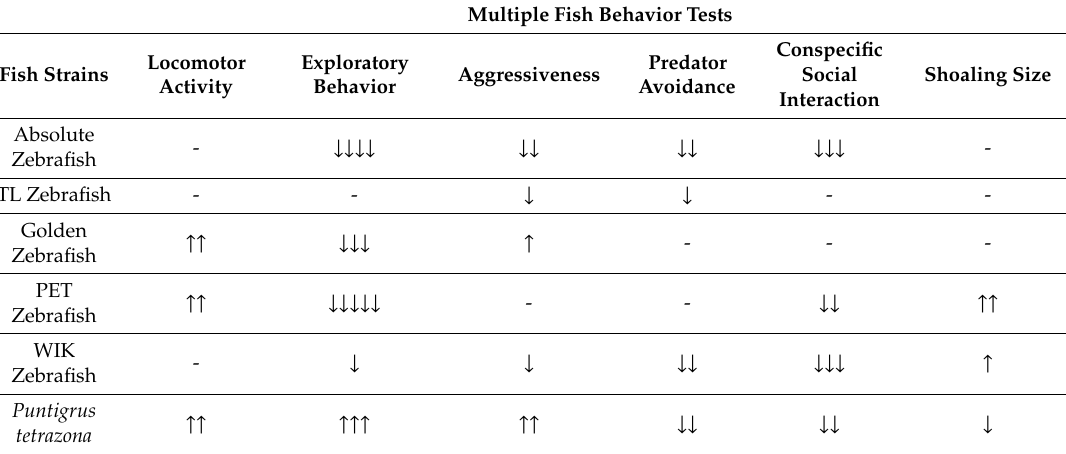
Table 1. The summary of several zebrafish strains’ behavioral di ff erences compared with the AB zebrafish. The signatures of the zebrafish behavioral tests are summarized ( ↑ : upregulated, ↓ : down-regulated, numbers of the arrow represent the number of altered behavior endpoints from